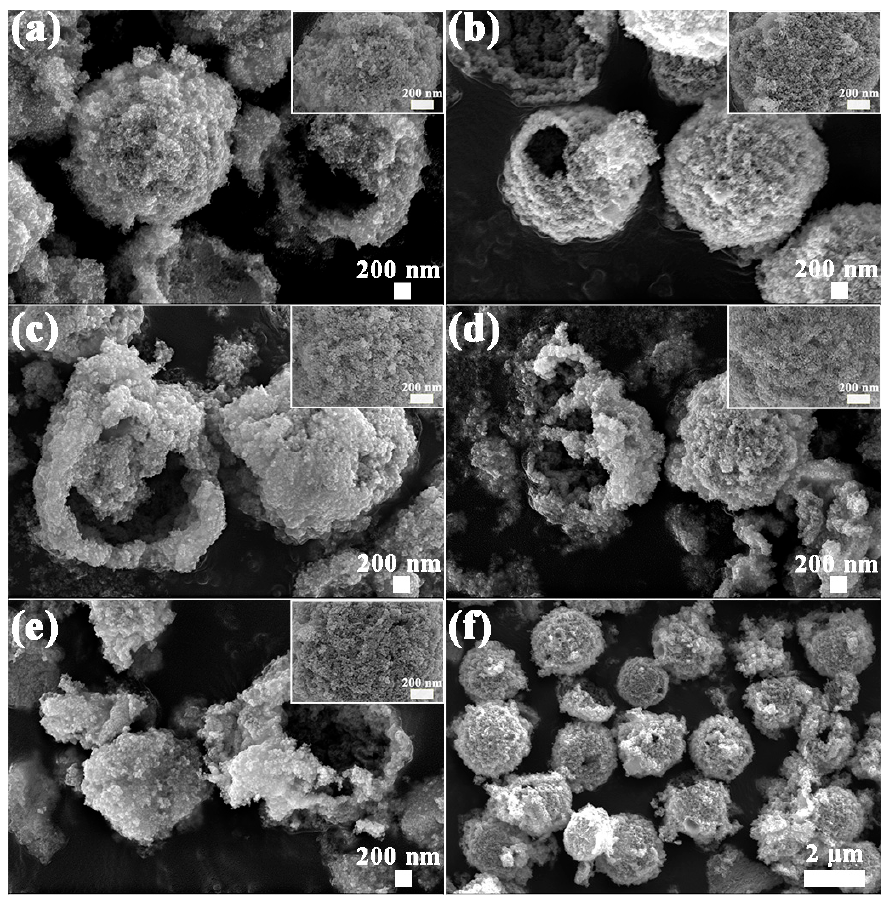
Figure 4. SEM images of S1–S5: ( a ) S1, ( b ) S2, ( c ) S3, ( d ) S4, ( e ) S5. ( f ) SEM image of S4 sample under low magnification.